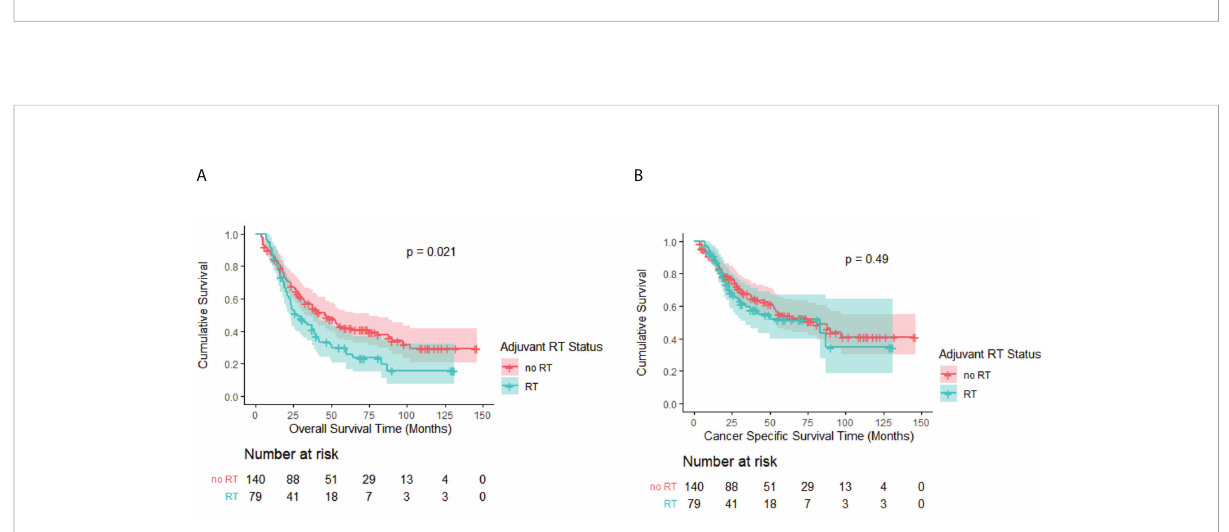
FIGURE 3 (A) Kaplan – Meier OS curve by adjuvant RT status after PSM. A signi fi cant difference was noted (P = 0.02). (B) Kaplan – Meier CSS curve by adjuvant RT status after PSM. No signi fi cant difference was observed (P =